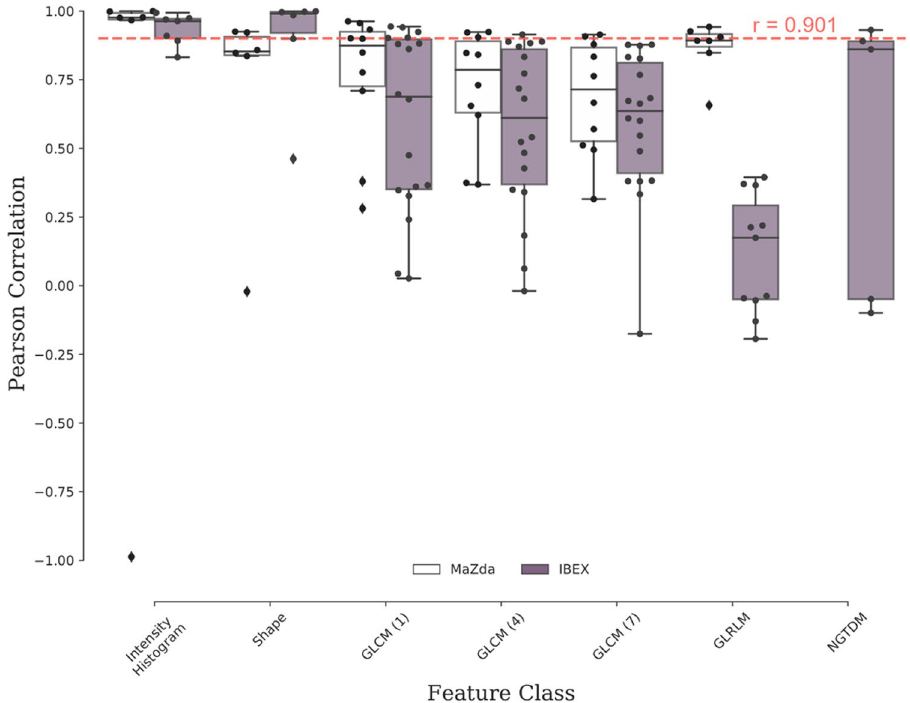
Figure 2. Linear correlation of apparent diffusion coefficient (ADC) radiomics features between IBEX and PyRadiomics software. Correlation matrices are grouped by feature class such as ( a ) intensity histogram ( b ) shape ( c ) NGTDM ( d – f ) GLCM and ( g ) GLRLM with colour representing the Pearson correlation coefficient (r). An ideal correlation matrix would have diagonal elements of highly correlated features (r = 1.0, dark purple) between software packages. A list of shared features between software packages is in Supplementary Tables